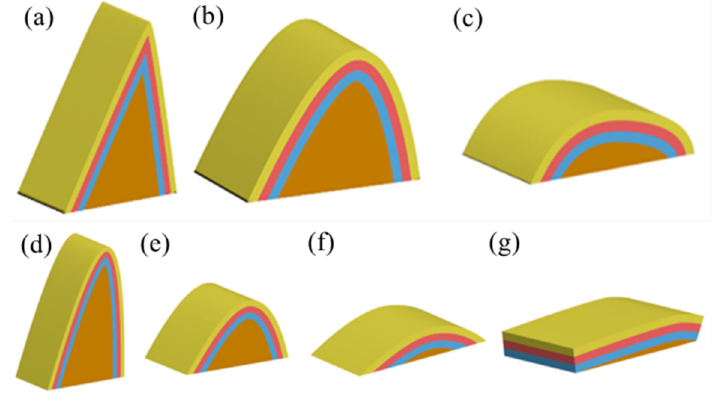
Figure 17. Other types of fold symbols obtained by setting the cur and θ parameters to different values, ( a ) cur = 0.8, chevron fold, ( b ) cur = 0.5, circular fold, ( c ) cur = 0.2, box fold, ( d ) θ = 30°, tight fold, ( e ) θ = 50°, closed fold, ( f ) θ = 100°, broad fold, and ( g ) θ = 160°, gentle fold. For a description of parameter cur and θ , please refer to Table 2. Entities with different colors represent different strata.